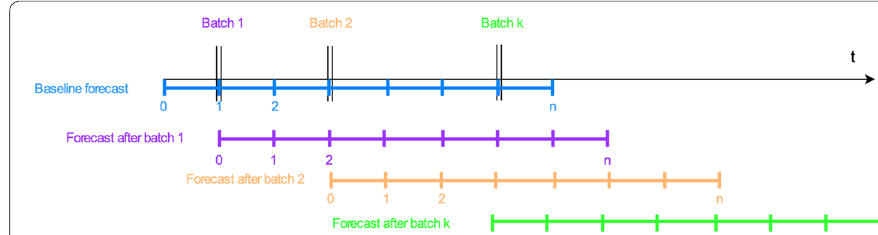
Fig. 6 Scheme of forecasting with data assimilation